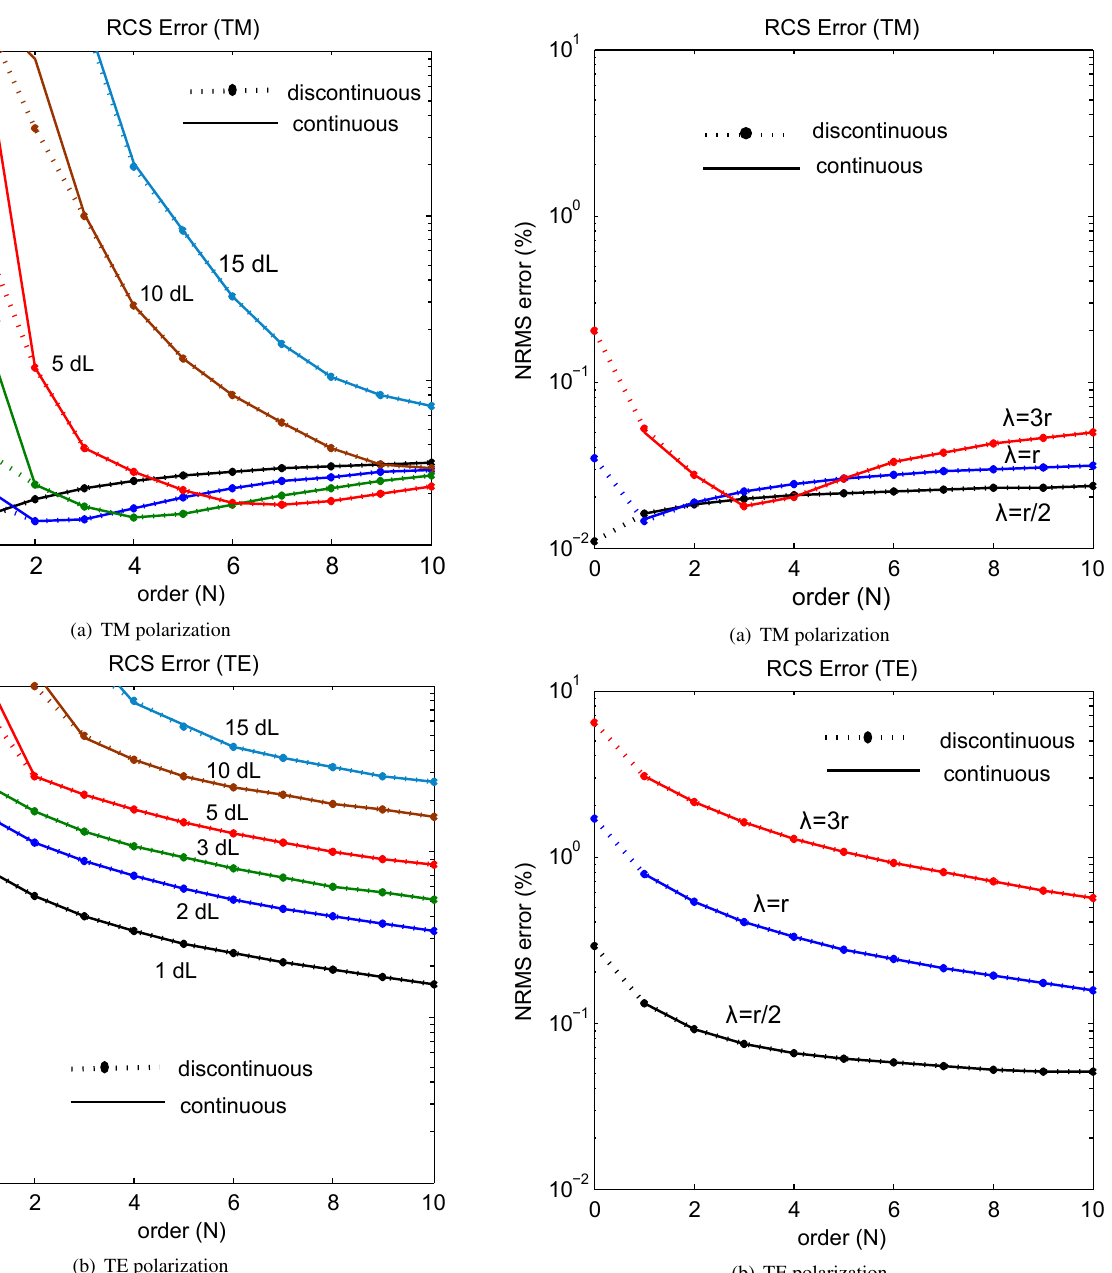
Figure 16: Log plot of RCS error versus the order and λ for L = 1 dL = λ/